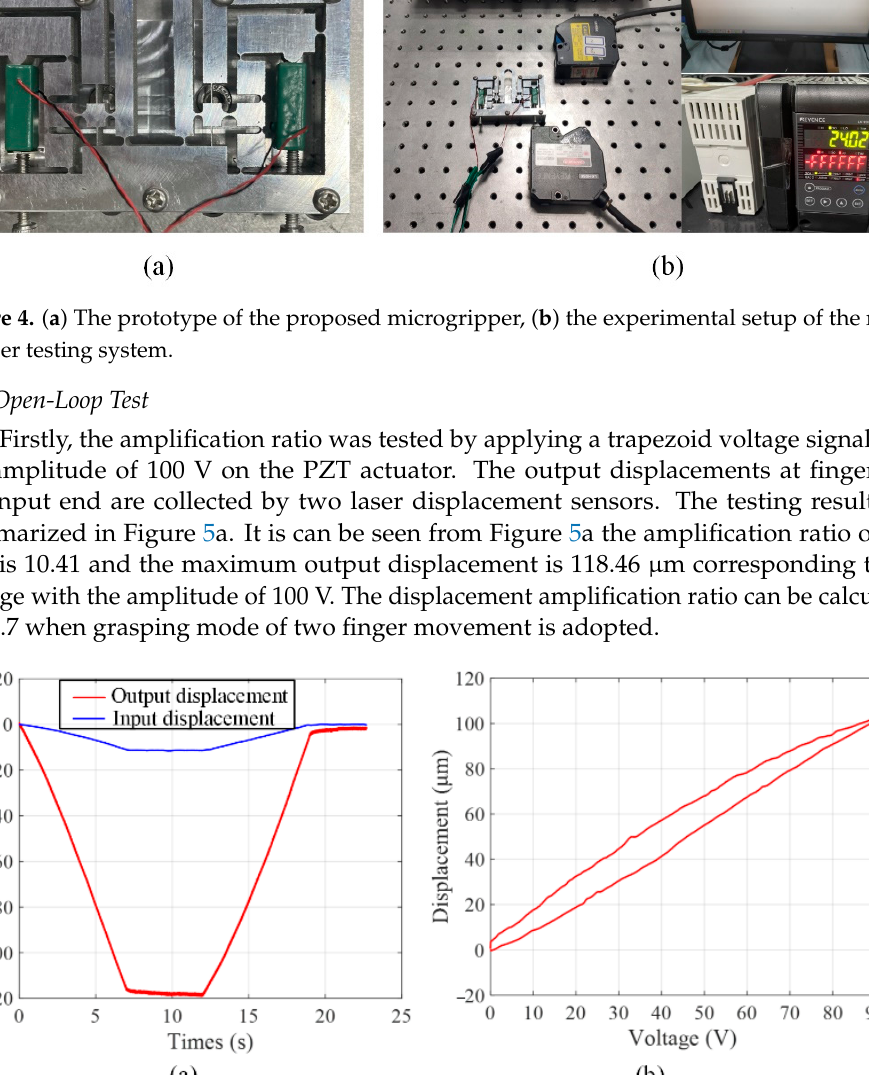
Figure 5. Open-loop tests of ( a ) amplification ratio test, ( b ) hysteresis nonlinearity test.